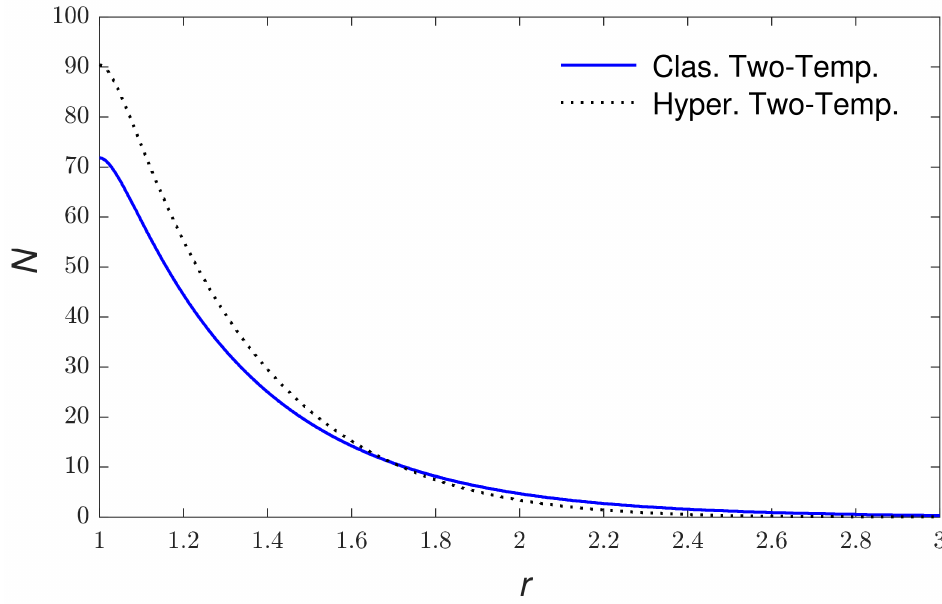
Figure 2. The carrier density variations versus the redial distance.